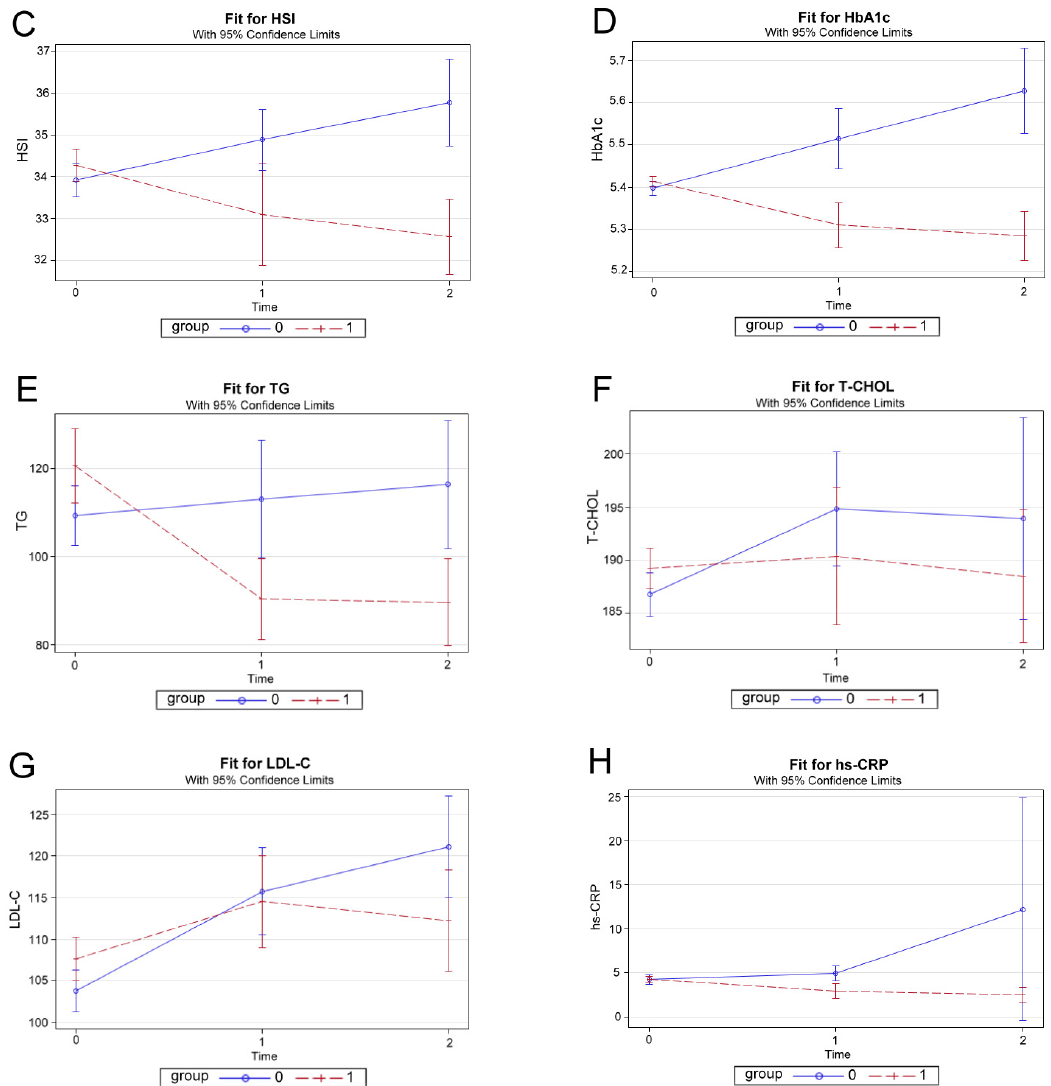
Figure 2. Plots of effects of zonisamide therapy, time fitted by generalized estimating equation (GEE) and adjusted for sex, age, and dependent variables (Y-axes) at baseline. ( A ) body weight; ( B ) body mass index; ( C ) hepatic steatosis index; ( D ) glycosylated hemoglobin; ( E ) triglycerides; ( F ) total cholesterol; ( G ) low-density lipoprotein cholesterol; ( H ) high-sensitivity C-reactive protein. Group 0, Control group; Group 1, Zonisamide group; time 0, baseline; time 1, 12 weeks; time 2, 24 weeks. We used GEE analysis rather than the two-way ANOVA because it was more appropriate for our data. BW, body weight; BMI, body mass index; HSI, hepatic steatosis index; HbA1c, glycosylated hemoglobin; TG, triglycerides; T-CHOL, total cholesterol; LDL-C, low-density lipoprotein cholesterol; hs-CRP, high-sensitivity C-reactive protein.